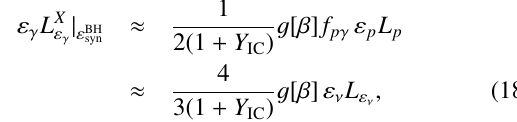
Figure 4. Schematic representation of the cosmic-ray beam model for high-energy neutrino production. While the neutrino emission is highly beamed the associated cascade emission in the X-ray range is